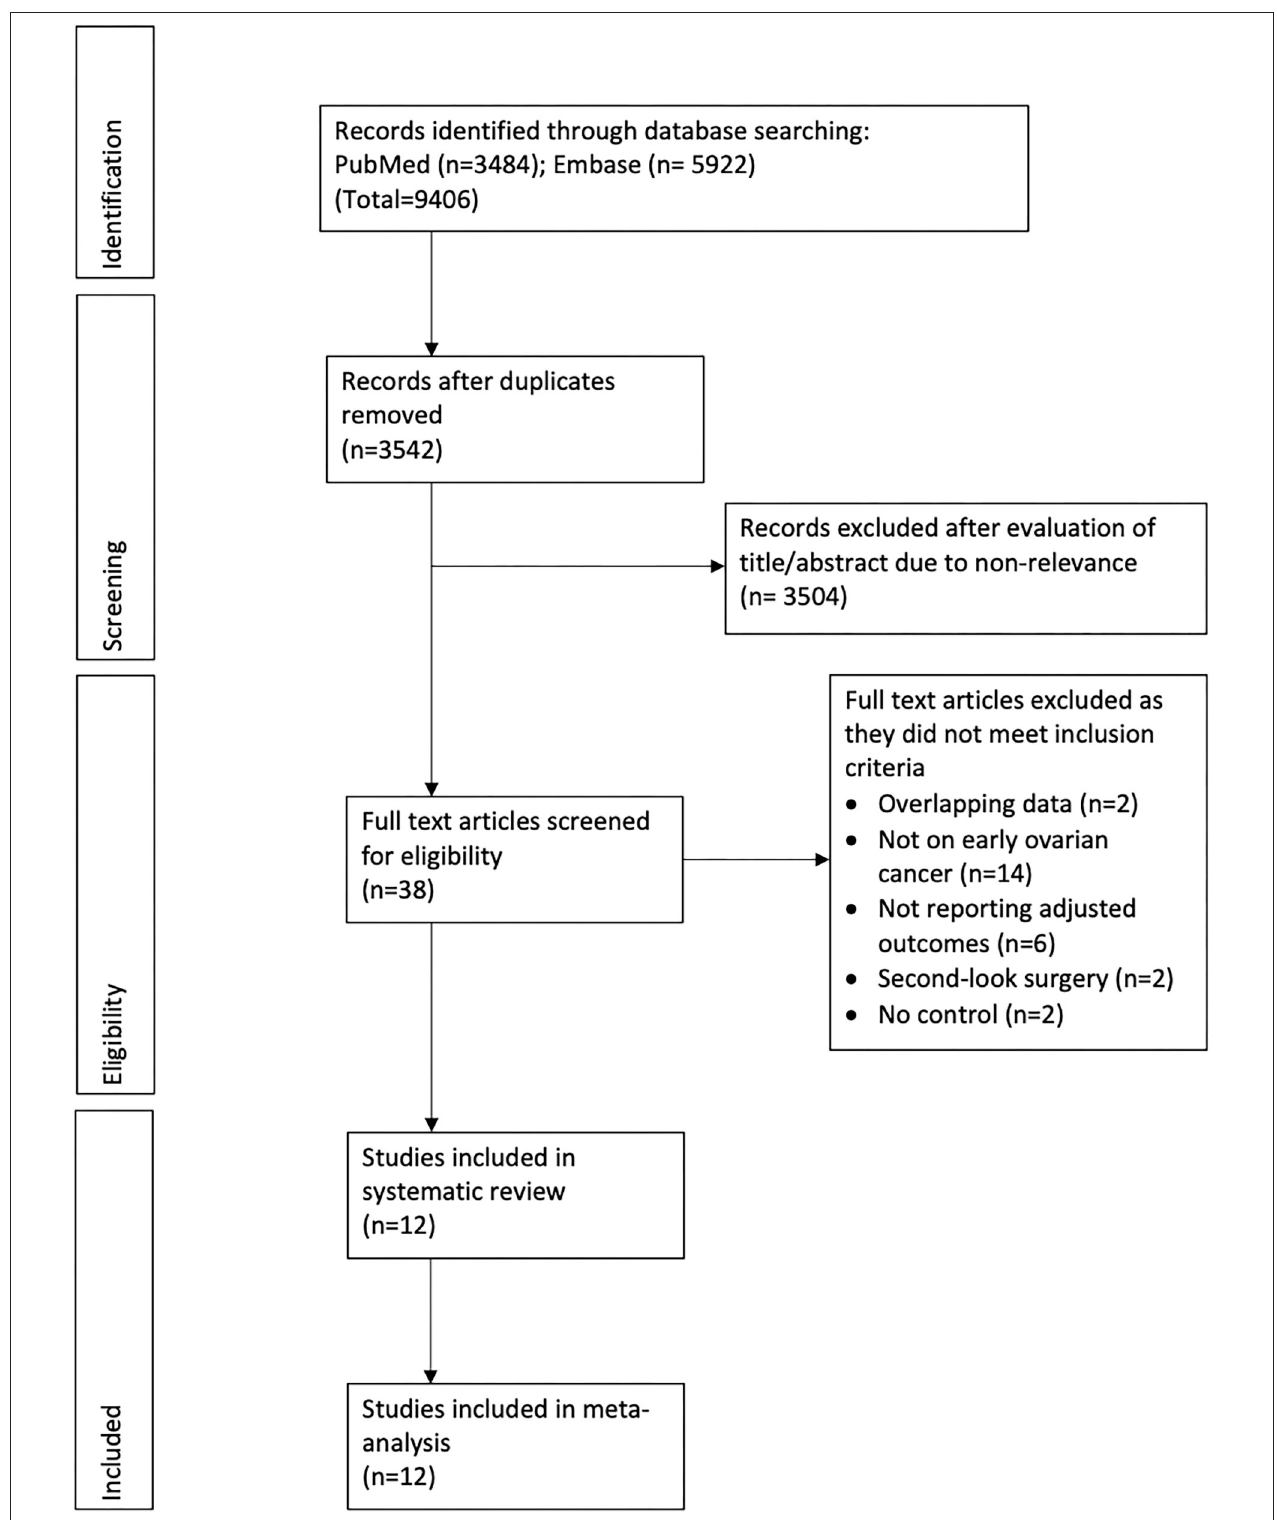
FIGURE 1 | Study flow